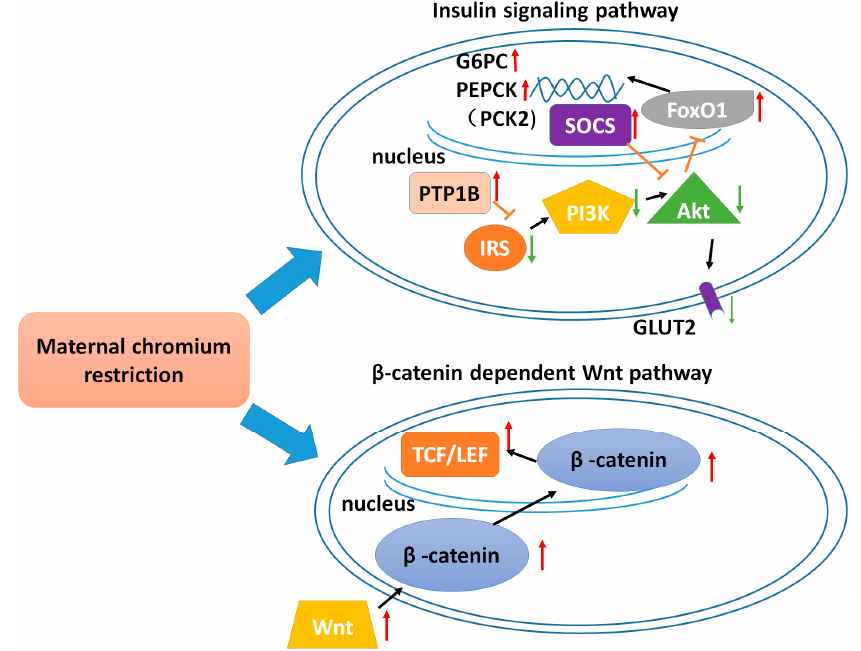
Figure 6. Schematic representation of maternal chromium restriction on the insulin signaling pathway and β -catenin-dependent Wnt pathway. In the Wnt pathway, maternal chromium restriction activates offspring liver β -catenin through Wnt, resulting β -catenin enters the nucleus. In nucleus, β -catenin binds to T cell factor/lymphoid enhancer factor (TCF/LEF) to activate target genes. In the insulin signaling pathway, maternal chromium restriction inhibits insulin receptor substrate (IRS)/phosphatidylinositol 3-kinase (PI3K)/Akt/protein kinase B (PKB) signaling pathway, enhancing the expression of G6PC and PEPCK to increase hepatic glucose production. Black arrows show the interaction of genes. T–bars show the inhibition of genes. Red arrows show upregulation of genes. Green arrows show downregulation of genes. SOCS: suppressor of cytokine signaling; Akt: thymoma viral proto-oncogene; IRS: insulin receptor substrate; PI3K: phosphatidylinositol 3-kinase; TCF/LEF: transcription factor/lymphoid enhancer factor; FOXO1: forkhead box O1; G6PC: glucose-6-phosphatase, catalytic; GLUT2: glucose transporter 2; PTP1B: protein tyrosine phosphatase, non-receptor type 1.